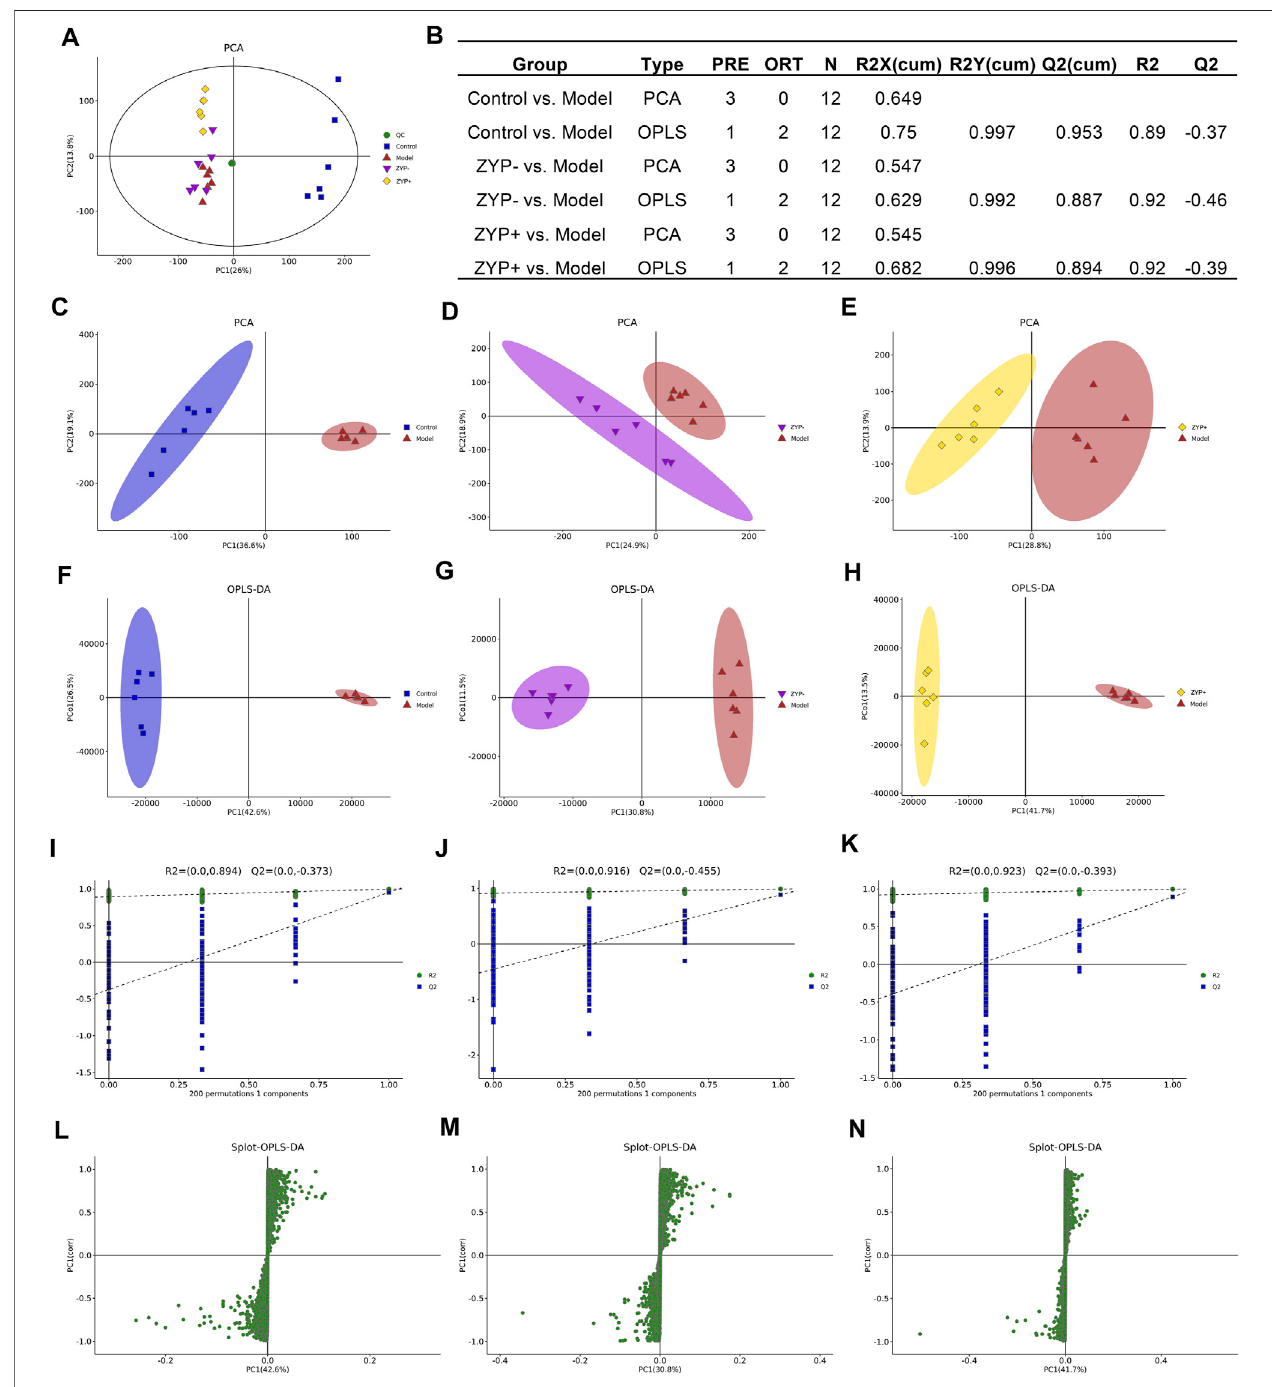
FIGURE2| Multivariatestatisticalanalysisofmetabolicpro fi lesderivedfromtheControl,Model,ZYP − ,andZYP+groups. (A) PCAscoreplotoftheControl,Model (ANIT),ZYP − ,ZYP+andQCgroups; (B) ParametersofPCA; (C – E) PCAofModelvsControlgroup,ZYP − vsModelandZYP+vsModel,respectively; (F – H) OPLS-DAof the Model vs Control group, ZYP − vs Model and ZYP+ vs Model, respectively; (I – K) 200-permutation test of the Model vs Control group, ZYP − vs Model and ZYP+ vs Model, respectively; (L – N) OPLS-DA score plot of the Model vs Control group, ZYP − vs Model and ZYP+ vs Model, respectively.